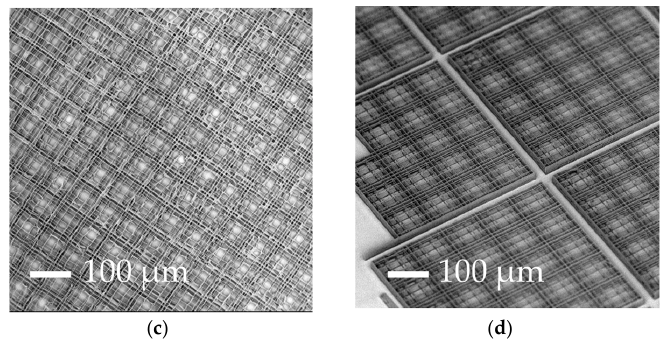
Figure 3. SEM images of the micro-fabrication after the optimization. ( a ) The culture substrate composed of three elementary nichoids patterned in a 200- μ m side triangle; ( b ) The culture substrate of elementary nichoids in a hexagonal layout (300 μ m side); ( c ) The culture substrate covered with continuously-packed nichoids (CPN), which share external walls with the adjacent ones; ( d ) The culture substrate covered with a fractionated supermatrix of nichoids (FSN), including 218 matrixes at a distance of 30 μ m.